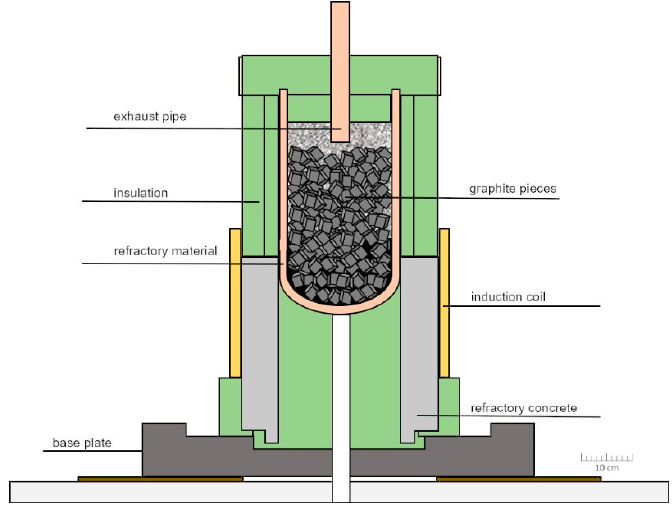
Figure 3. ( a ) Schematic representation of the original InduMelt plant (Design 1) [34]; ( b ) overall setup in test operation.